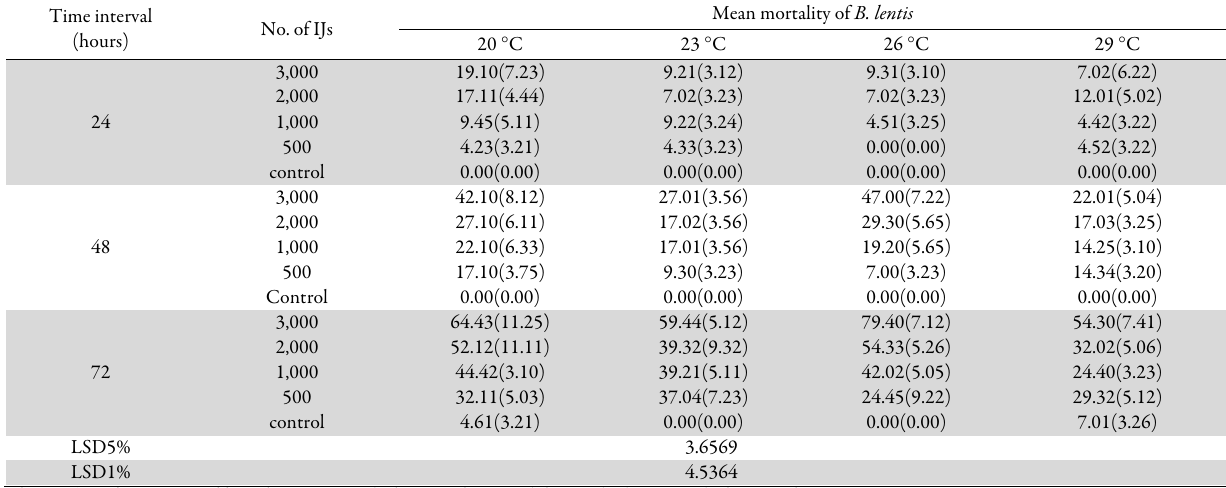
Table 2. Percentage mortality of adult B. lentis due to effect of S. feltiae in different temperatures and times Time interval